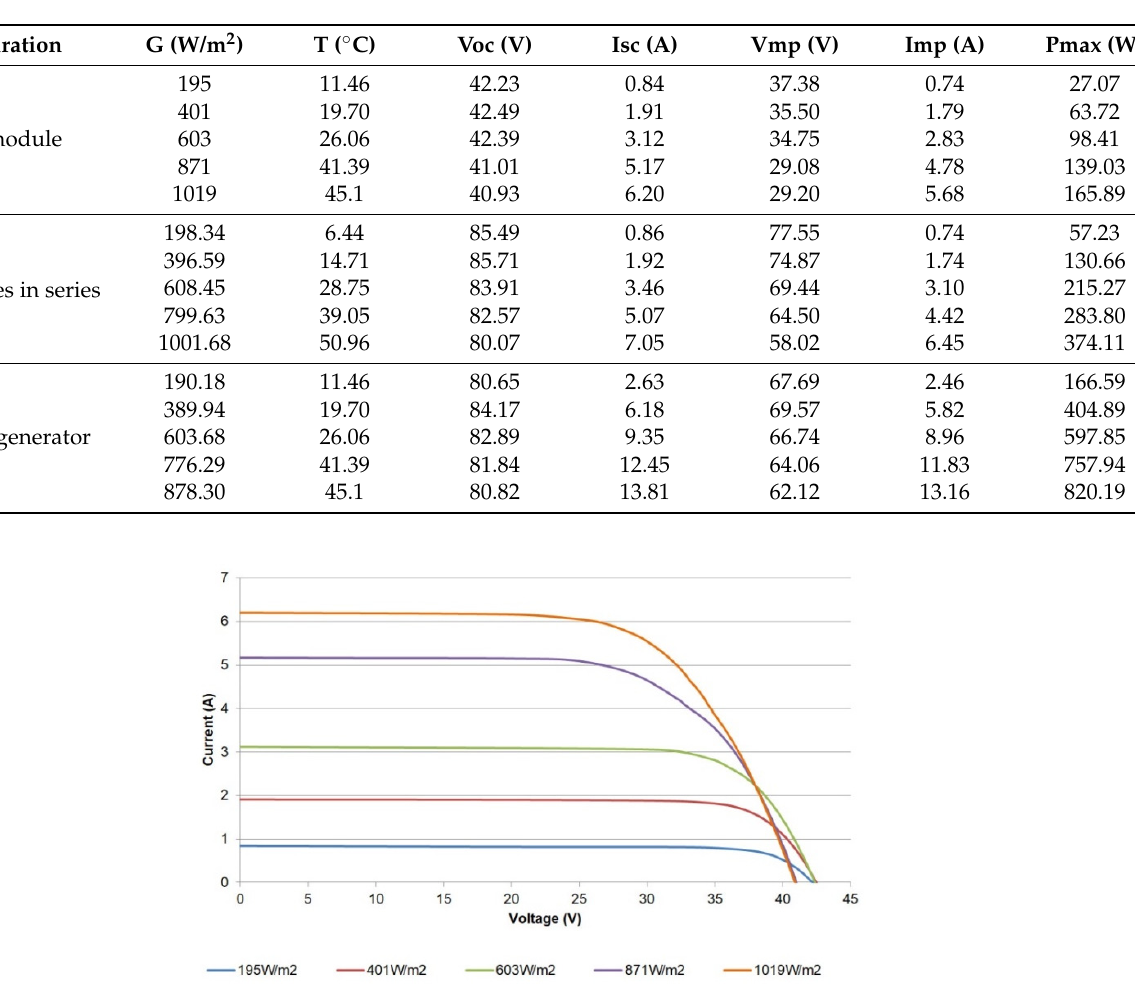
Figure 15. P ‐ V curves for a single PV module.